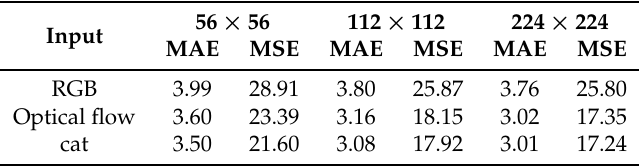
Table 4. Influence of different input on the